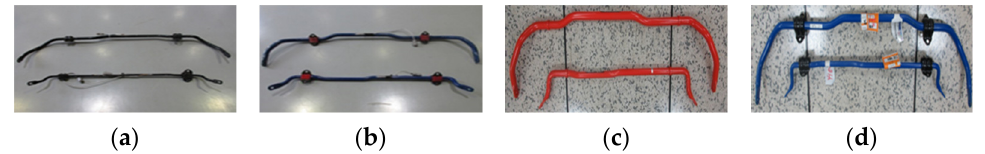
Figure 5. Target stabilizer bar parts(front/rear): ( a ) Reference Stabilizer bar, ( b ) Stabilizer bar A, ( c ) Stabilizer bar B, and ( d ) Stabilizer bar C.